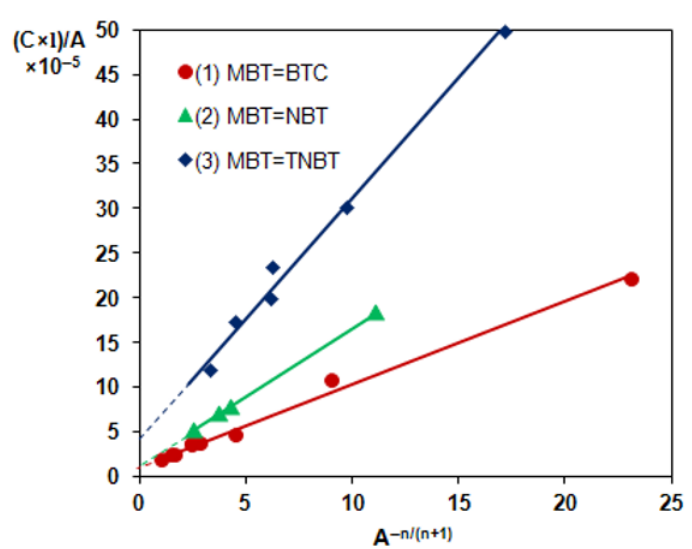
Figure 7. Straight lines obtained by the Komar-Tolmachev method [43] during the determination of the constants of association ( β ) and true molar absorptivities ( ε ). C (1) y=9.168×10 –6 x+1.233×10 –5 ; (2) y=1.539×10 –5 x+1.421×10 –5 ; (3) y=2.643×10 –5 x+4.735×10 –5 . Table 5. Calculated values (P=95%) of the extraction constants (K and molar absorptivities ( ε ). Extraction